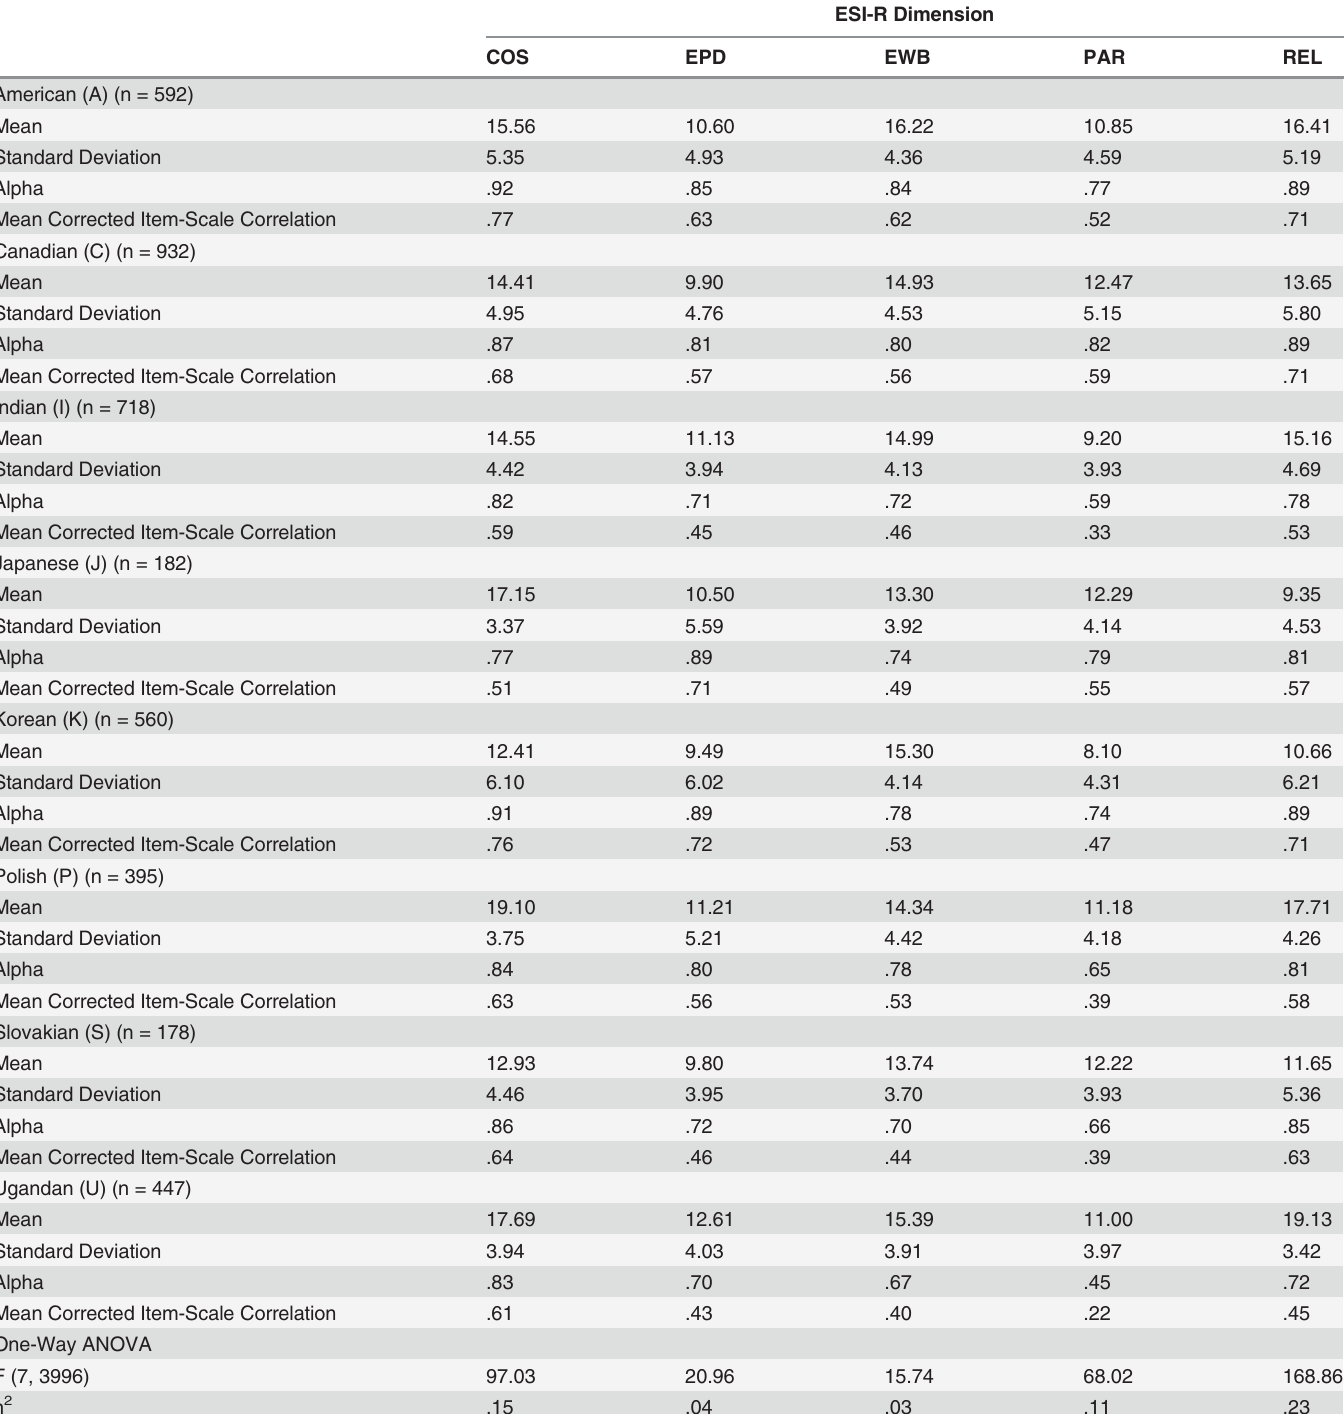
Table 5. Descriptive and Reliability Statistics and One-way ANOVA results for ESI-R Dimensions as a Function of